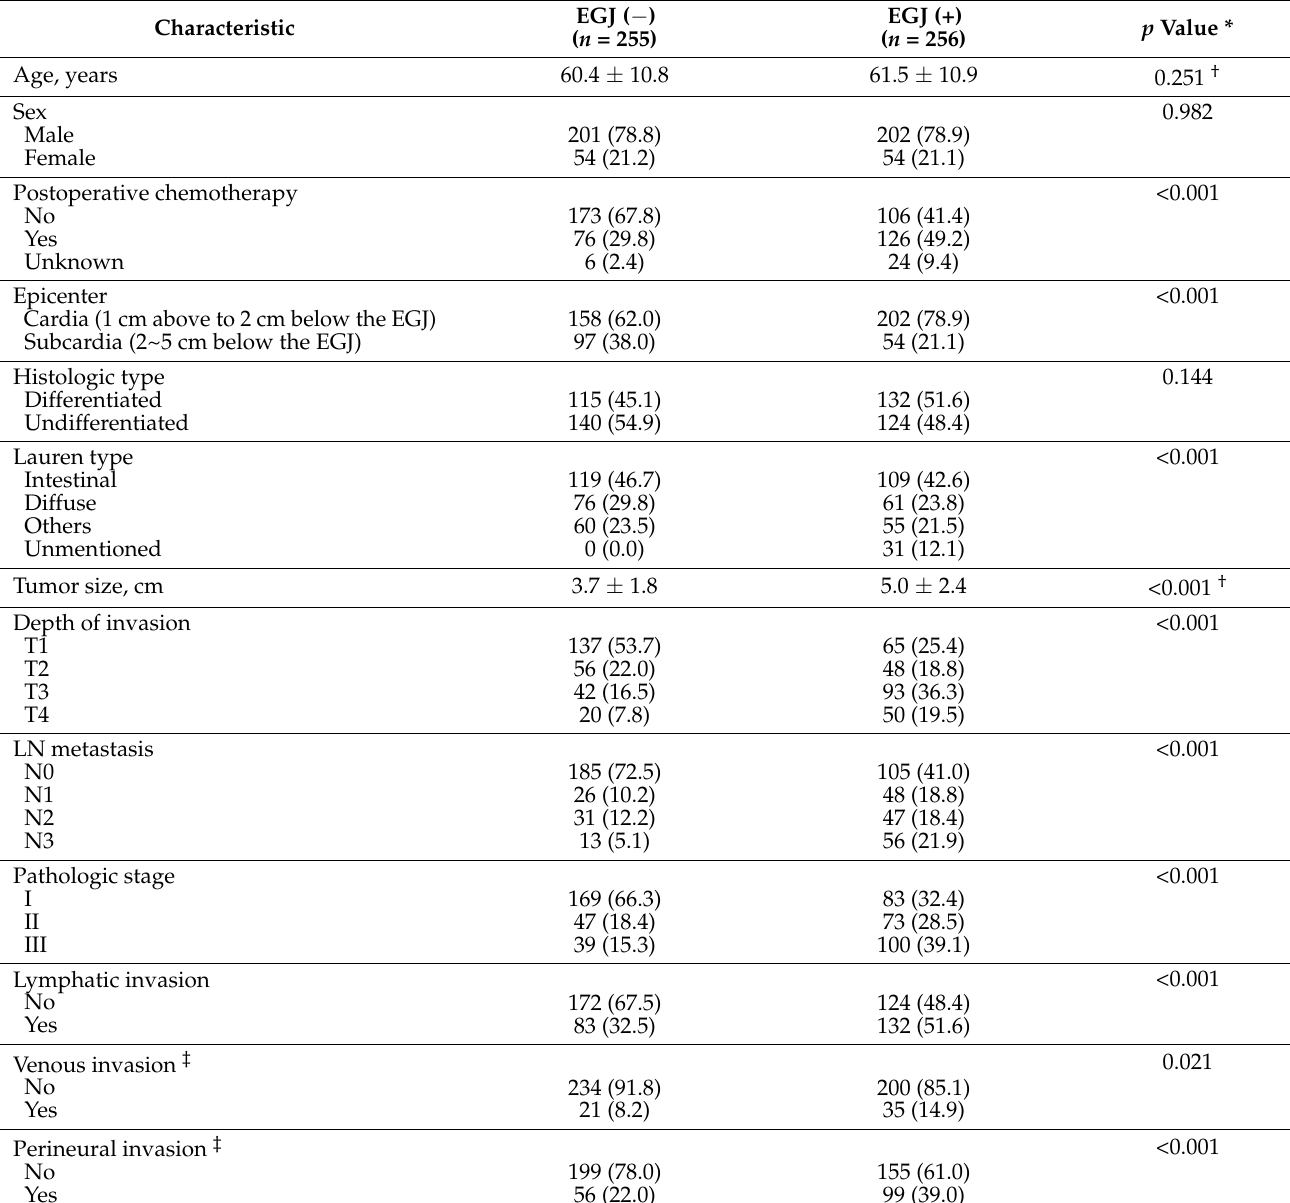
Table 2. Clinicopathologic characteristics of patients diagnosed with cardia or subcardia cancer categorized according to invasion of the esophagogastric junction